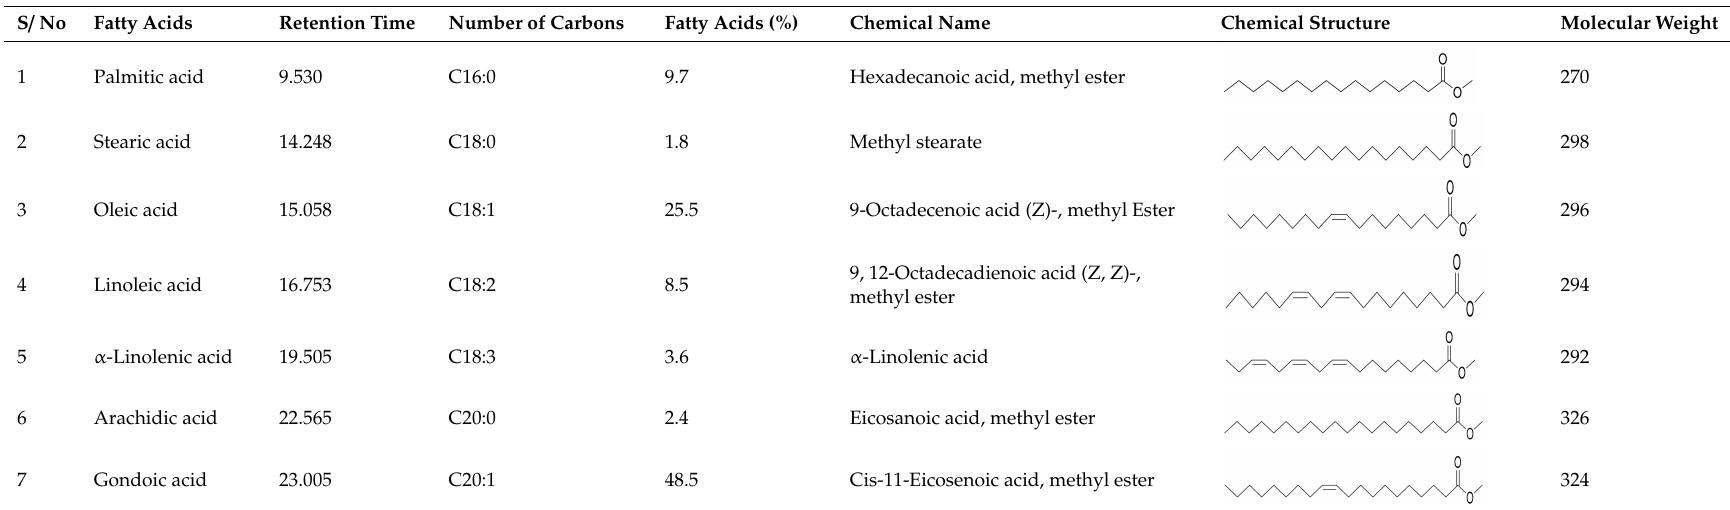
Table 3. Koelreuteria paniculata seed oil biodisel fatty acid